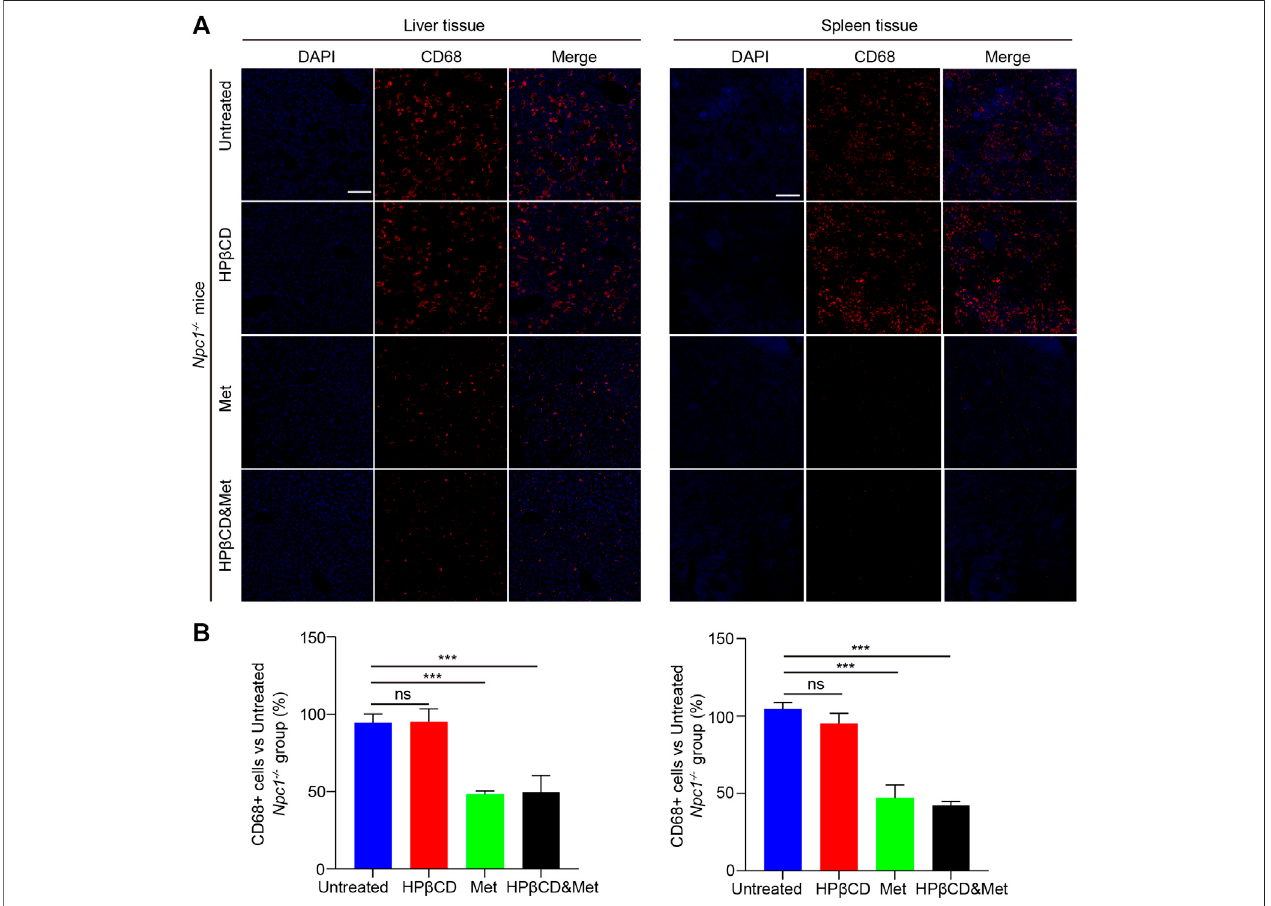
FIGURE 4 | Effects of test drugs on CD68 expression in Npc1 − / − liver and spleen. Representative images of Iba1 and CD68 expression in the liver (left) and spleen (right)intheindicatedgroups (A) ( n (cid:1) 4)(scalebar:100 μ m).QuantitativeanalysisofIba1andCD68positivecellsusingImageJ (B) .Signi fi cantdifferencesweredetected by one-way ANOVA followed by Dunnett ’ s test, ns represents not signi fi cant, *** p < 0.001. versus untreated group.